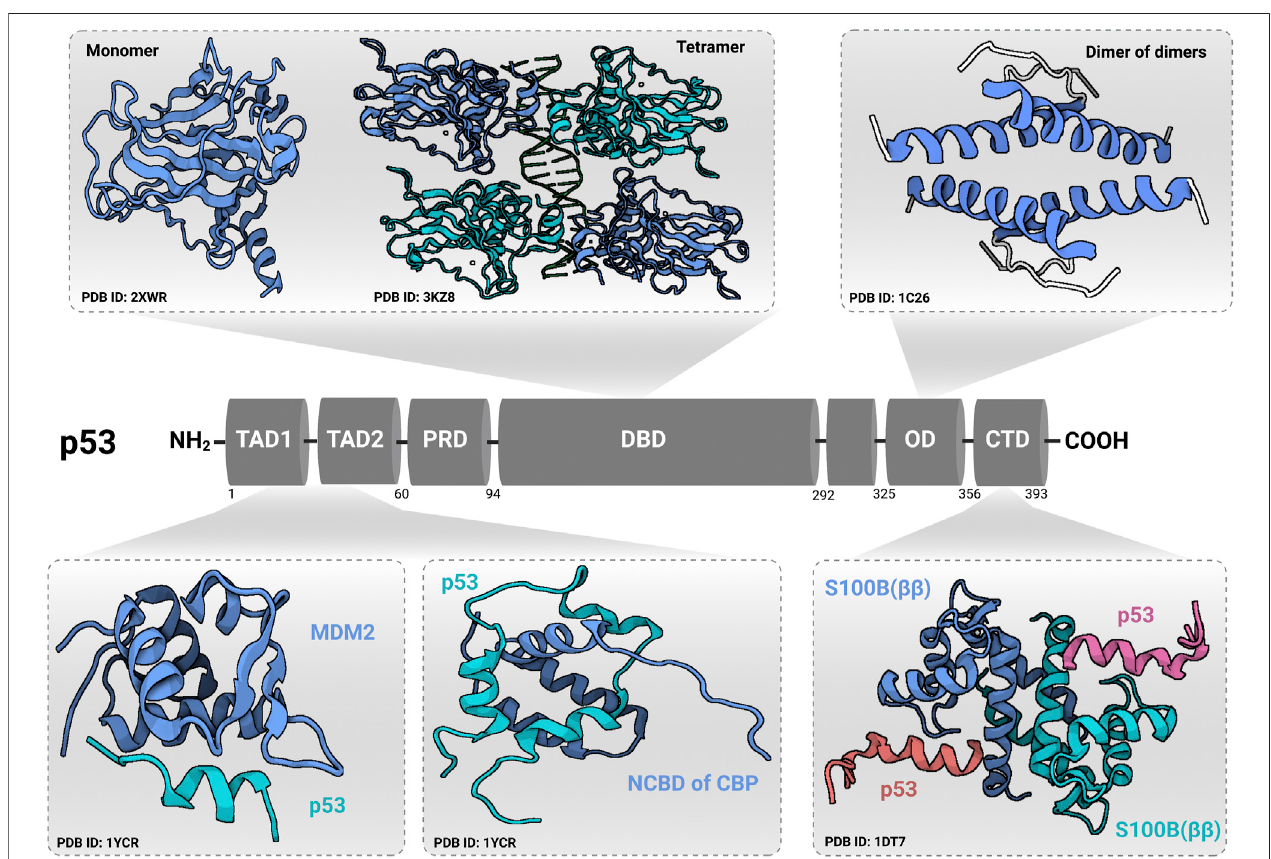
FIGURE 2 | Domain structure of p53. p53 contains an N-terminal transactivation domain (TAD), which can be subdivided into the subdomains TAD1 and TAD2, followed by a conserved proline-rich domain (PRD). The DNA-binding domain (DBD) and tetramerization/oligomerization domains (OD) are connected through a linker region. At the C-terminal end, p53 has a regulatory region called C-terminal domain (CTD). Transactivation domain (TAD) and C-terminal domain (CTD) structures were identi fi ed in complex with other regulatory proteins [shown for Mouse double minute 2 homolog (MDM2), nuclear coactivator-binding domain (NCBD) of CREB- binding protein ( CBP), and S100B ( ββ ) protein]. Protein Data Bank identi fi cation numbers for domain structures are given below each structure. The fi gure was created (Joerger and Fersht, 2016) using (www.app.biorender.com).